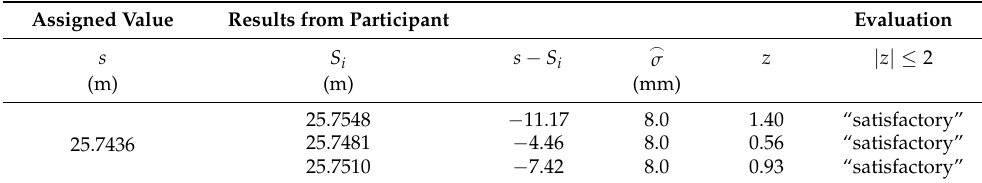
Table 5. Score z , for the distance S 1-2 ( i = AGROS; “Vekom Net”; “GentooARS”). Assigned Value Results from Participant